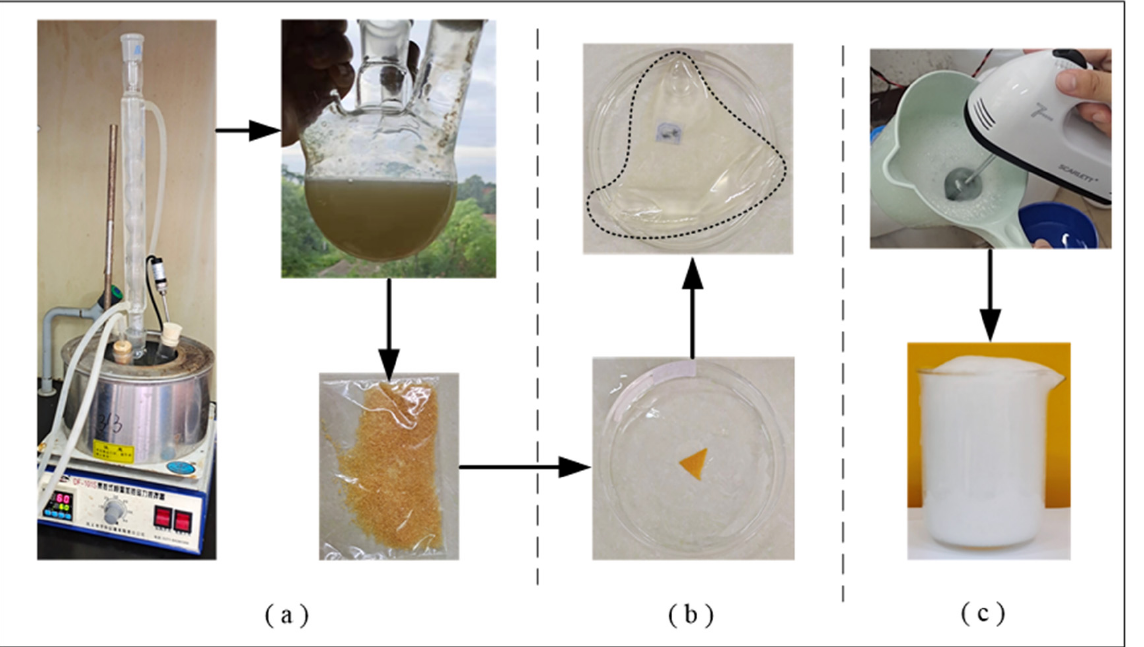
Figure 3. Schematic diagram of experimental process. ( a ) preparation of superabsorbent foam stabilizer. ( b ) water absorption test of foam stabilizer sample. ( c ) preparation of gel foam.